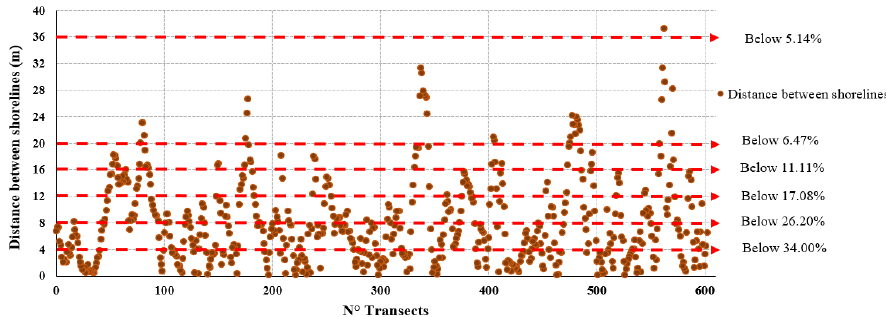
Figure 14. Analysis of the accuracy of shoreline extraction method.